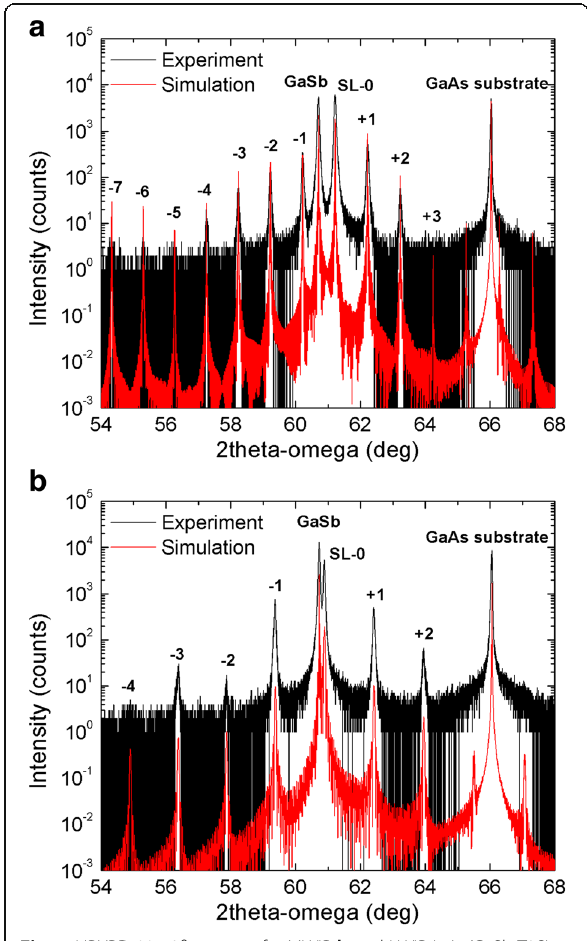
Fig. 1 HRXRD 004 2 θ - ω scan of a MWIR b and LWIR InAs/GaSb T2SLs. Experimental (black line) and simulated (red line) HRXRD 2 θ - ω scans for the (004) reflection of a MWIR T2SL; there are well-resolved satellites with an order up to 4, which is a characteristic of good quality of superlattice. The FWHM of the zeroth-order peak is 107 arcsec, b and LWIR InAs/GaSb T2SLs; there are satellite peaks with an order up to 7, which confirms the high crystalline quality. The FWHM of the zeroth- order peak is 99 arcsec. The period of each superlattice is calculated from the distance between adjacent